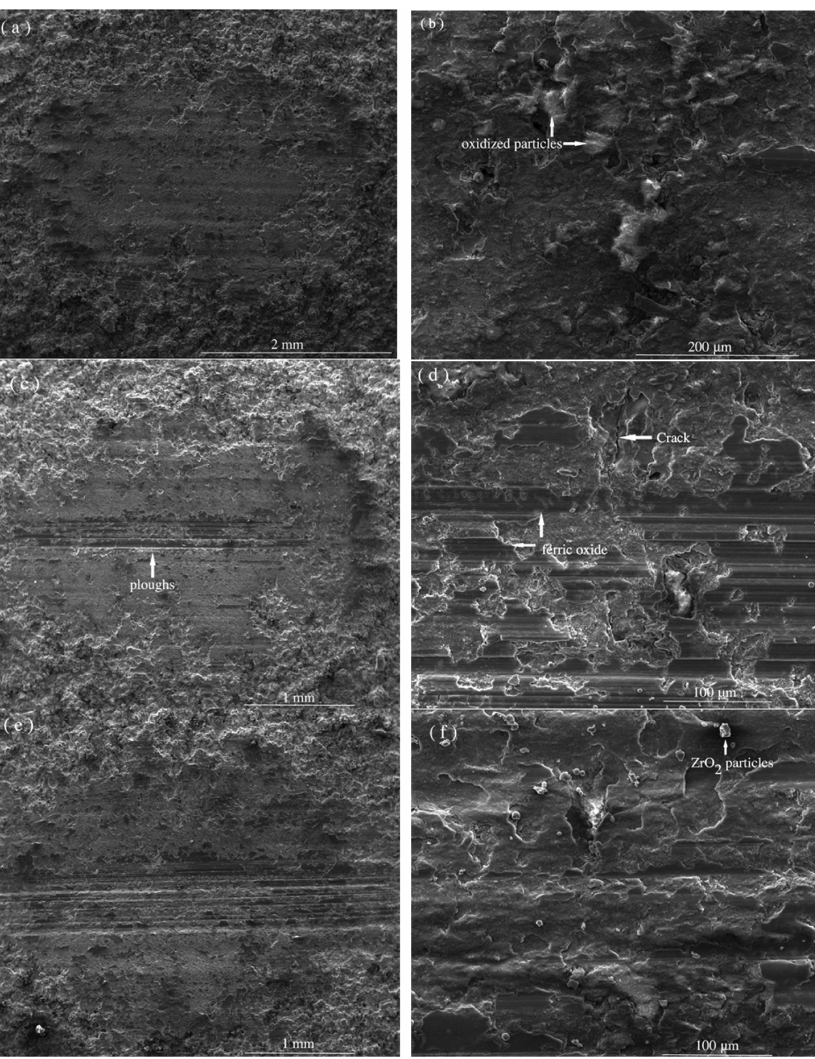
Figure 10: Worn surface morphologies of AS-MC (a-b) 50N, (c-d) 100N, (e-f)